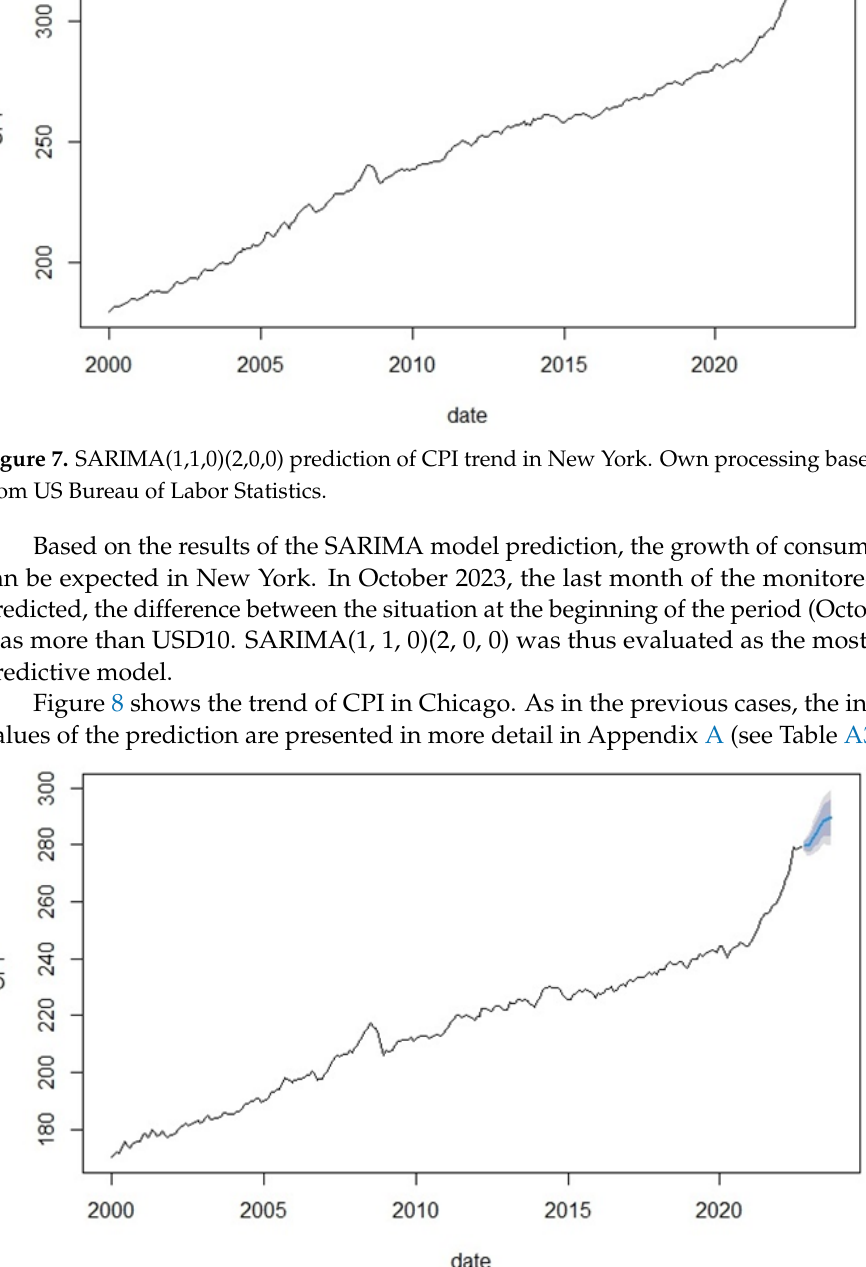
Figure 8. SARIMA(1,1,1)(2,0,0) prediction of CPI trend in Chicago. Own processing based on data from US Bureau of Labor Statistics.